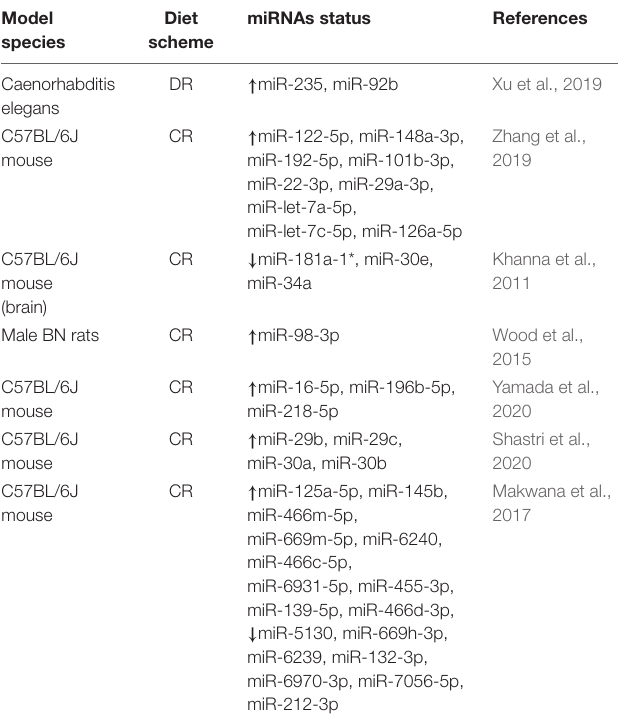
TABLE 1 | CR/DR regulates the expression of aging-related